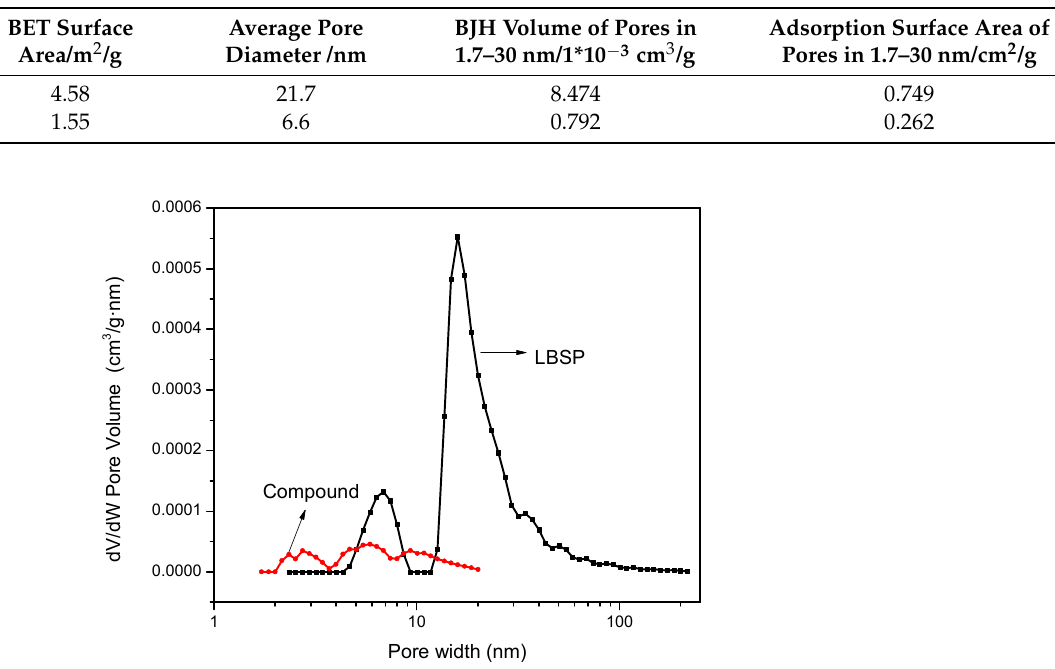
Figure 10. The derivative in pore volume, dv/dw, in the LBSP and PCE/LBSP compound. As shown in Figure 11, the hydraulic diameter distribution of PCE-1 in an aqueous solution (DI water) varied from 4.1 nm to 8.7 nm, with the maximum diameter of 5.6 nm. In contrast, in SCPS, the hydrodynamic diameter distribution ranged from 4.1 nm to 11.7 nm, where the maximum diameter was 7.5 nm. This result shows that the PCE-1 polymer could enter the voids in the LBSP particles since the polymer had a smaller hydrodynamic diameter than the LBSP pore size. As a consequence, the BJH pore volume of PCE/LBSP compound was reduced.